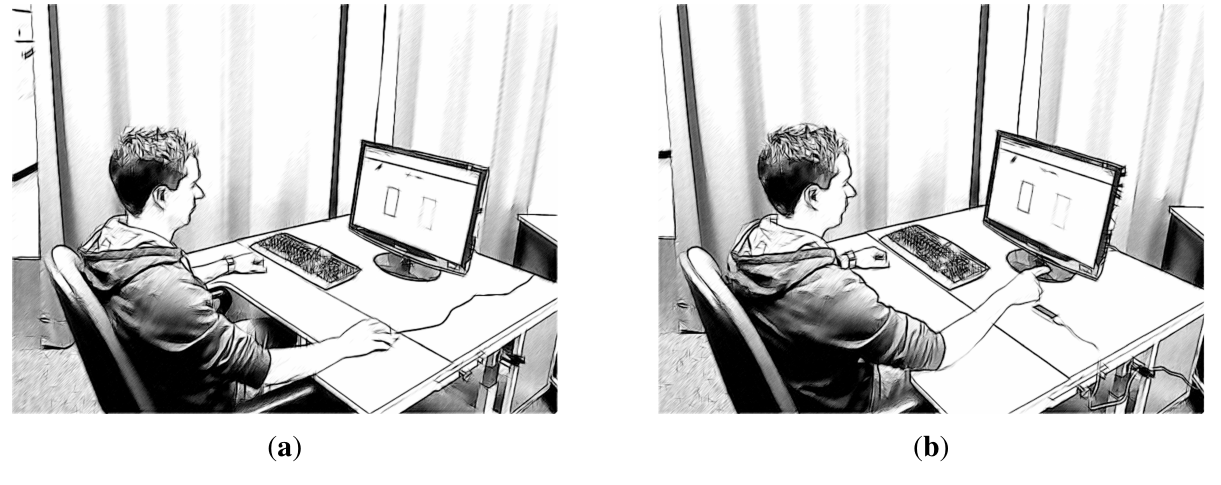
Figure 2. Experimental set-up: ( a ) participant using the mouse controller and ( b ) utilizing the Leap Motion Controller (LMC) to perform selection